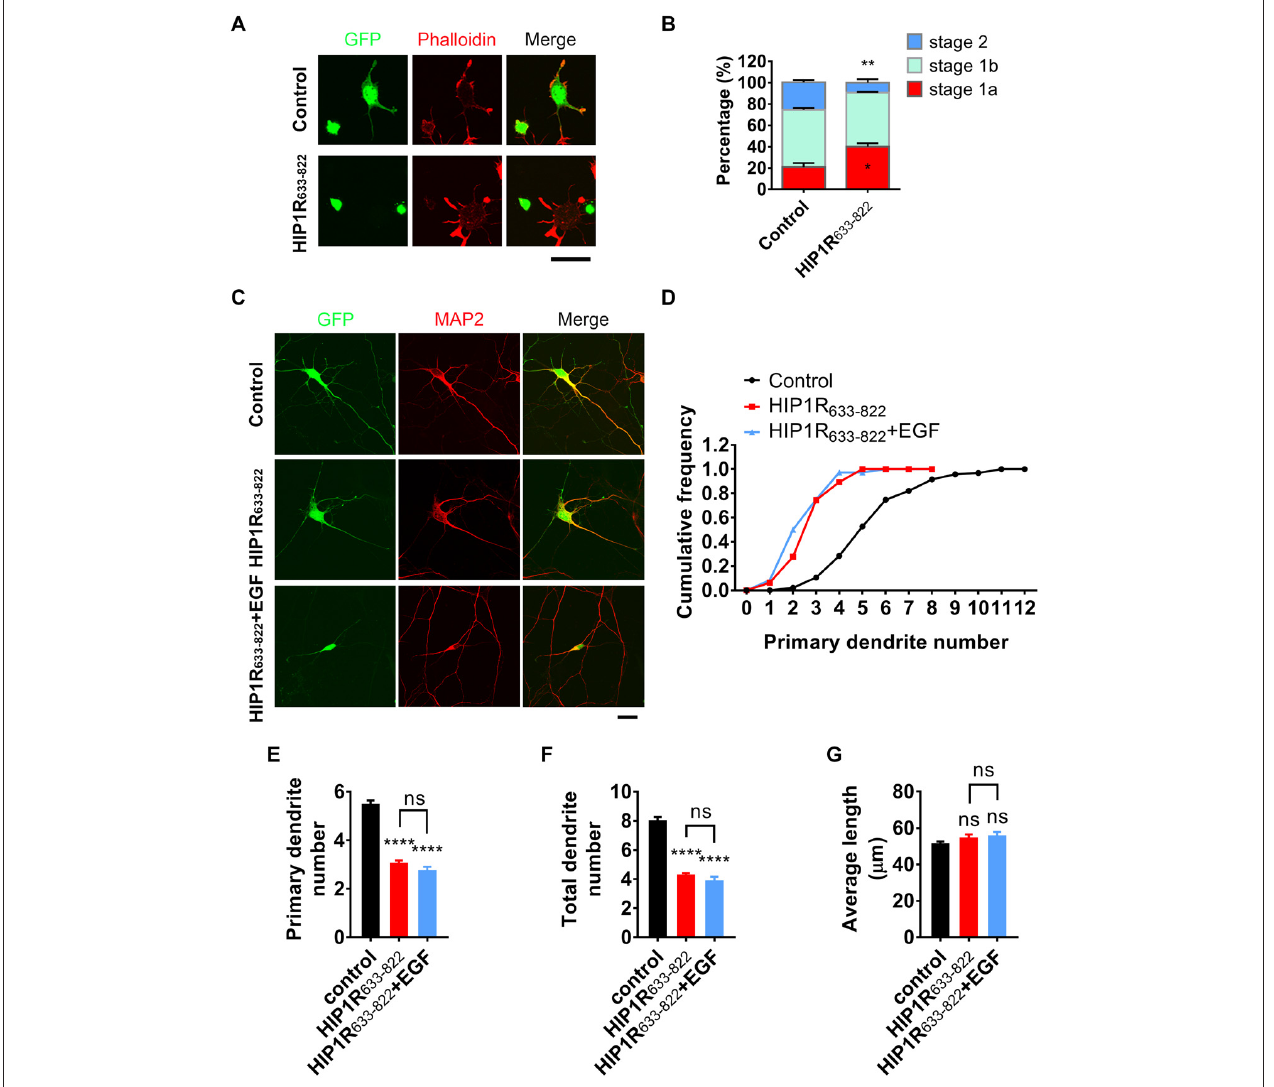
FIGURE 8 | HIP1R 633–822 overexpression disturbs neurite initiation and dendritic branching. (A) Representative images of cultured neurons electroporated with GFP-control) and GFP-HIP1R 633–822 constructs, fixed 5–6 h after plating, and labeled for GFP (green), MAP2 (blue) and phalloidin (red). (B) Quantification of neurite initiation in control and HIP1R 633–822 groups ( n = 1,150 and 1,368 neurons). (C) Representative images of cultured neurons transfected with GFP or GFP-HIP1R 633–822 and fixed at DIV 5–6. MAP2 staining outlined the dendrites. Scale bar, 20 µ m. (D) Cumulative distribution of primary dendritic number of control and HIP1R 633–822 groups. (E–G) Quantification of dendritic number and dendritic length of neurons in control and HIP1R 633–822 groups ( n = 86 and 47 neurons). Data are presented as mean ± SEM, ns, not significant > 0.05; ∗ p < 0.05; ∗∗ p < 0.01; ∗∗∗∗ p < 0.0001; ≥ 3 independent experiments; unpaired two-tailed t